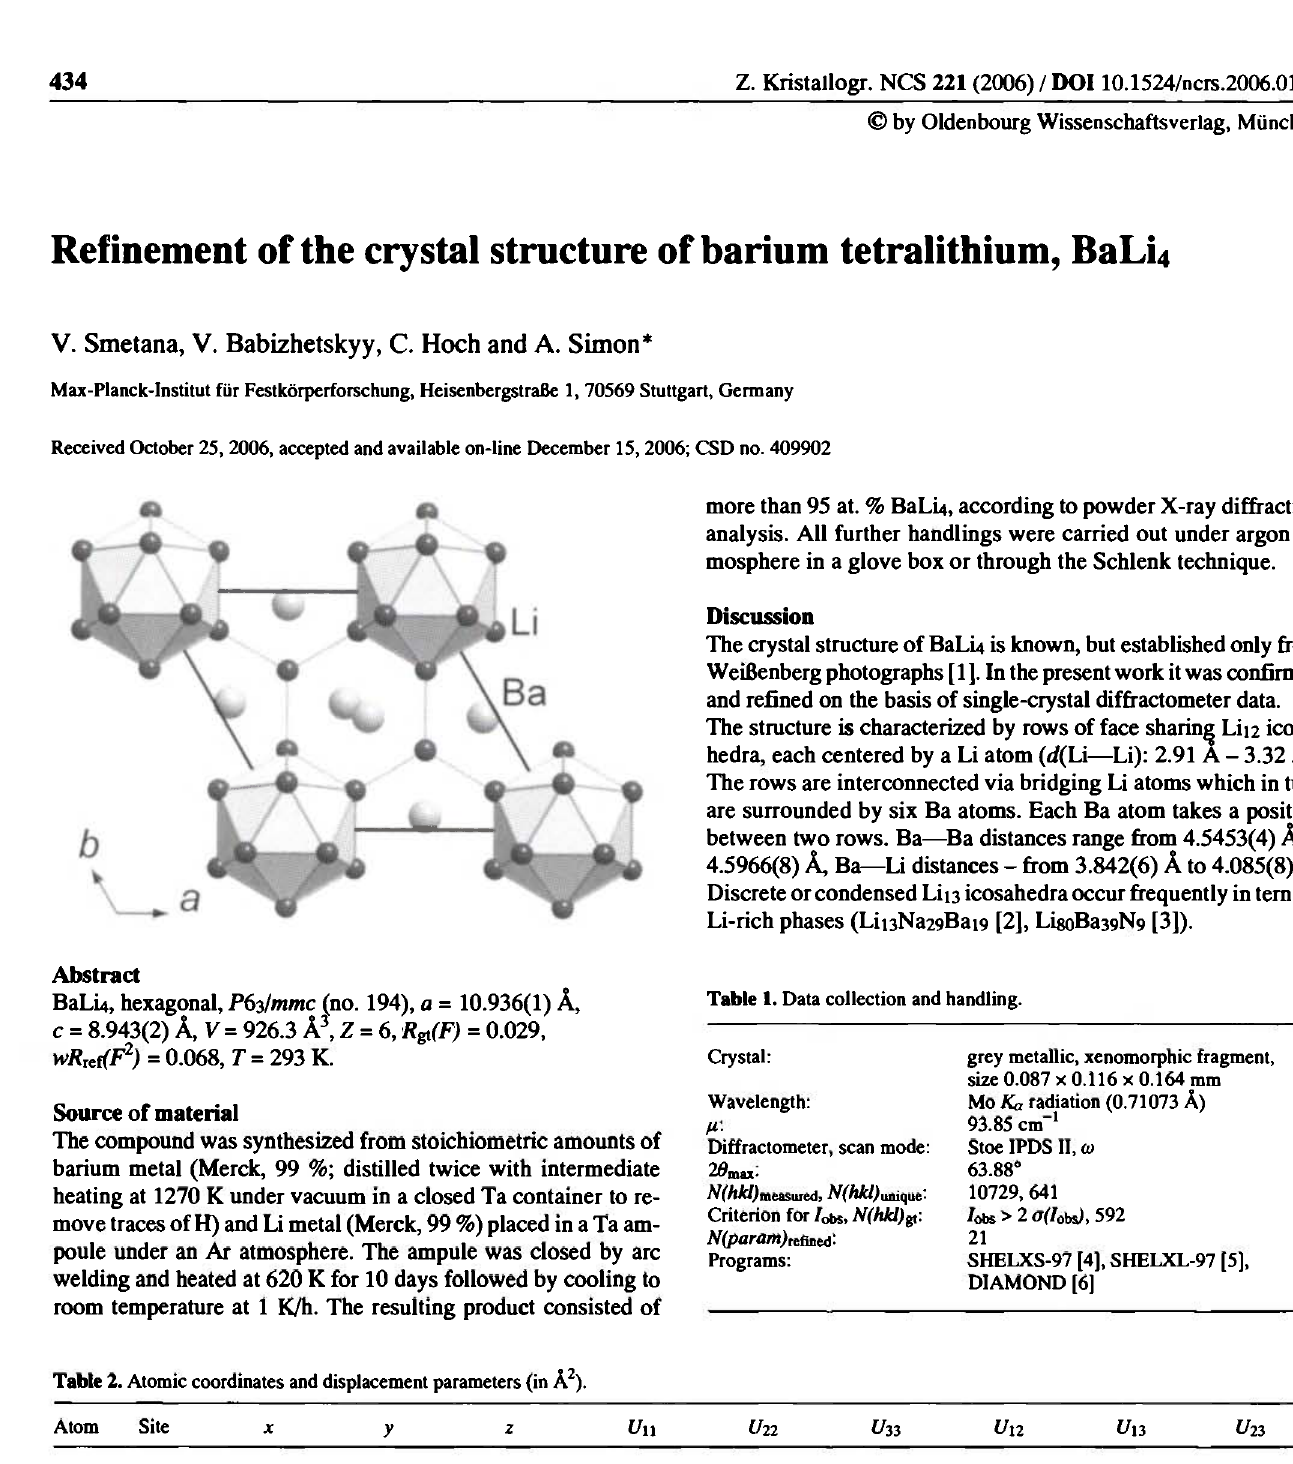
Table 2. Atomic coordinates and displacement parameters (in A 2